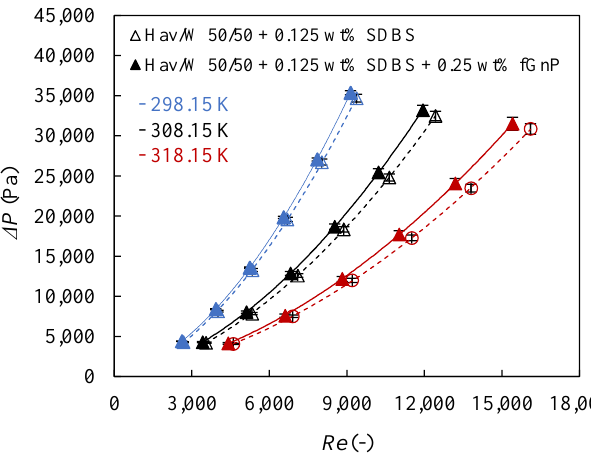
Figure 7. Reynolds number, Re , dependence on pressure drop, ΔP , for 0.25 wt% nanofluid and the base fluid at different temperatures. Error bars indicate the expanded uncertainty (k = 2).